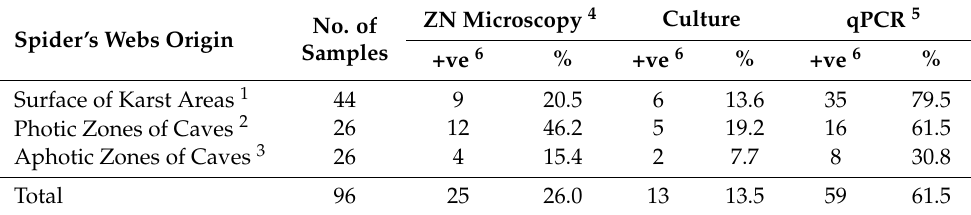
Table interpretation. 1 Bohemian ( n = 11), Hranice ( n = 11), and Moravian ( n = 22) Karst Systems in the Czech Republic; 2 Karst Caves in the Czech Republic: Bohemian ( Srbsko-Stary Propad , Lom na Chlumu-Srbska , and Skvira Caves, n = 3), Hranice ( Zbrasov Aragonite Caves, n = 17), Moravian ( Pekarna , Kostelik , and Jachymka Caves, n = 3), in Sicily in Italy (Cave Monte Conca , n = 2), and in Slovakia ( Liscia Diera Cave, n = 1); 3 Karst Systems in the Czech Republic: Hranice Karts ( Zbrasov Aragonite Caves, n = 3) and Moravian Karst ( Sloupsko-Sosuvsky Cave System, n = 16 and Byci Skala Cave System, n = 1), in France: Duganelle Cave ( n = 1), and in Slovakia: Bezstropa Caves, Kopcova Skala , Hradisko , and Janik Caves ( n = 5); 4 microscopy examination after the Ziehl-Neelsen staining was done in at least 200 fields [41]; 5 quantitative PCR test (qPCR values on a logarithmic scale detection between 3 to 4); 6 +ve = positive